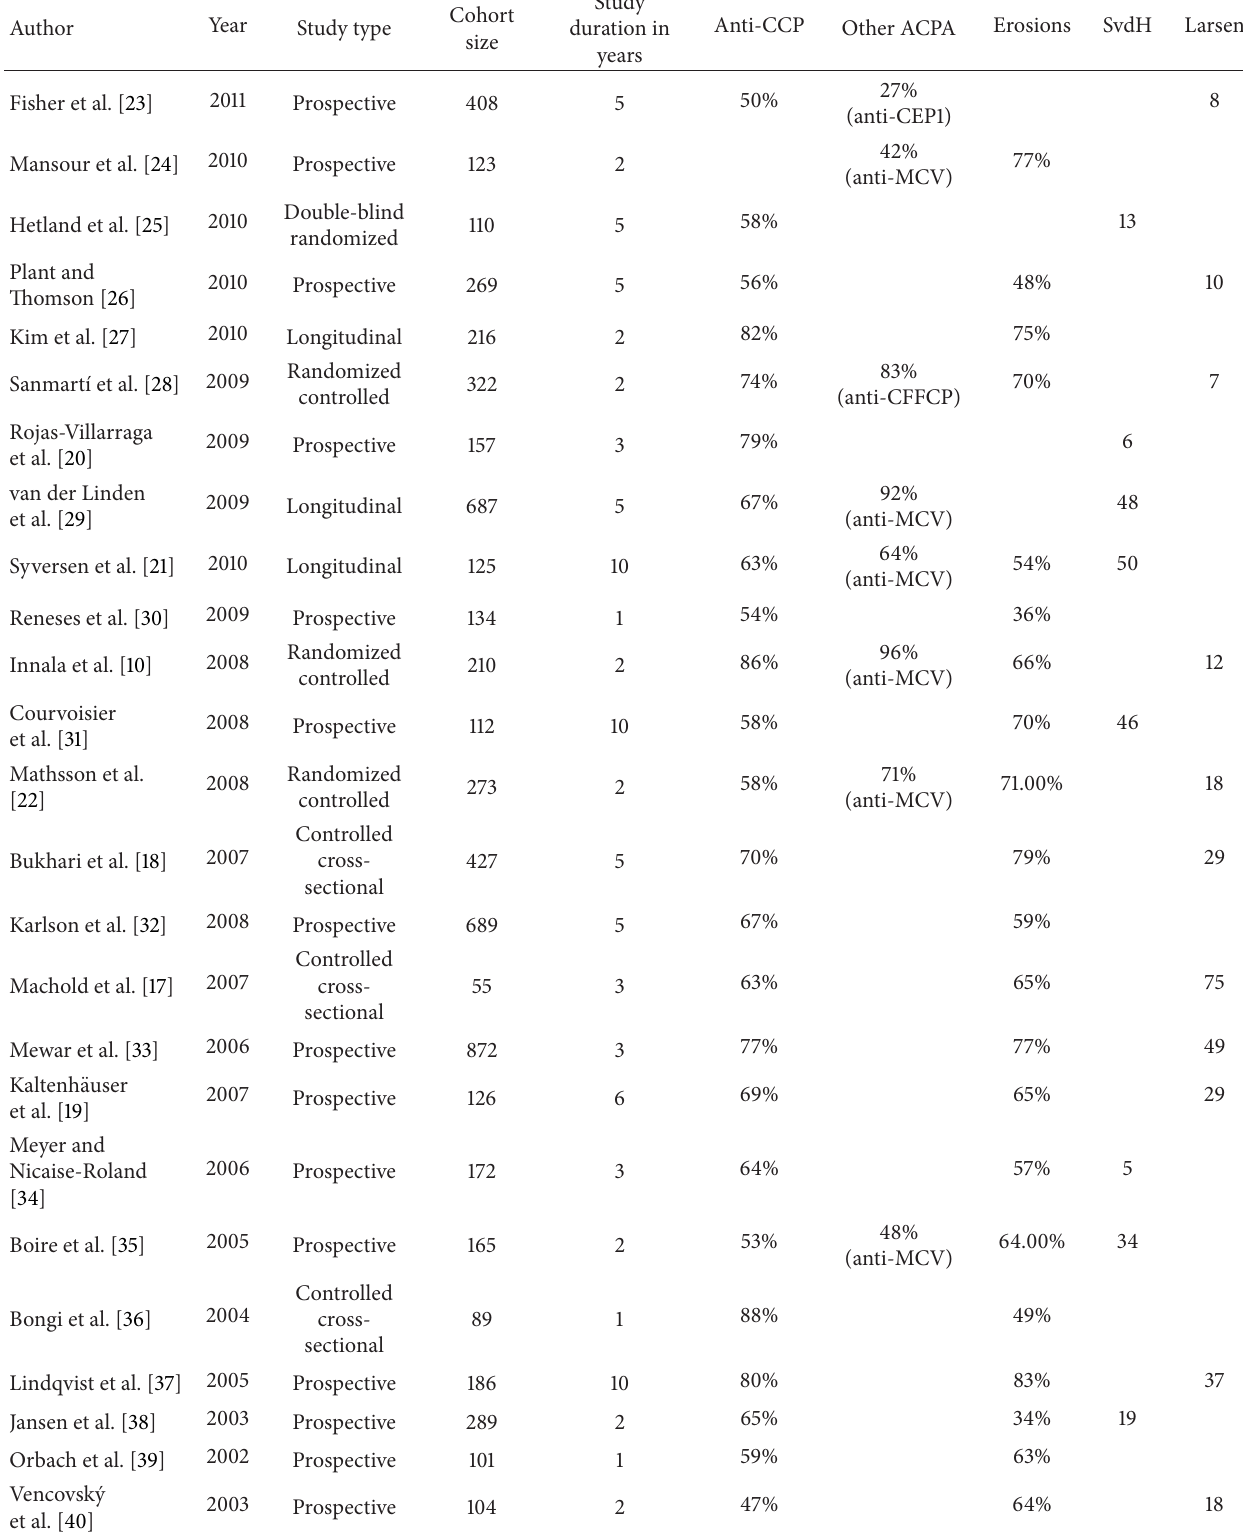
Table 1: Studies included in the systematic